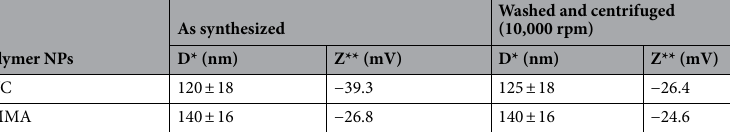
Table 1. Size and surface charges of the PMMA and PVCs NPs from DLS measurements in water before and after washing. *D: Hydrodynamic diameter (nm). **Z: Zeta-potential (mV), PDI values where 0.05 for PVC and 0.07 for PMMA